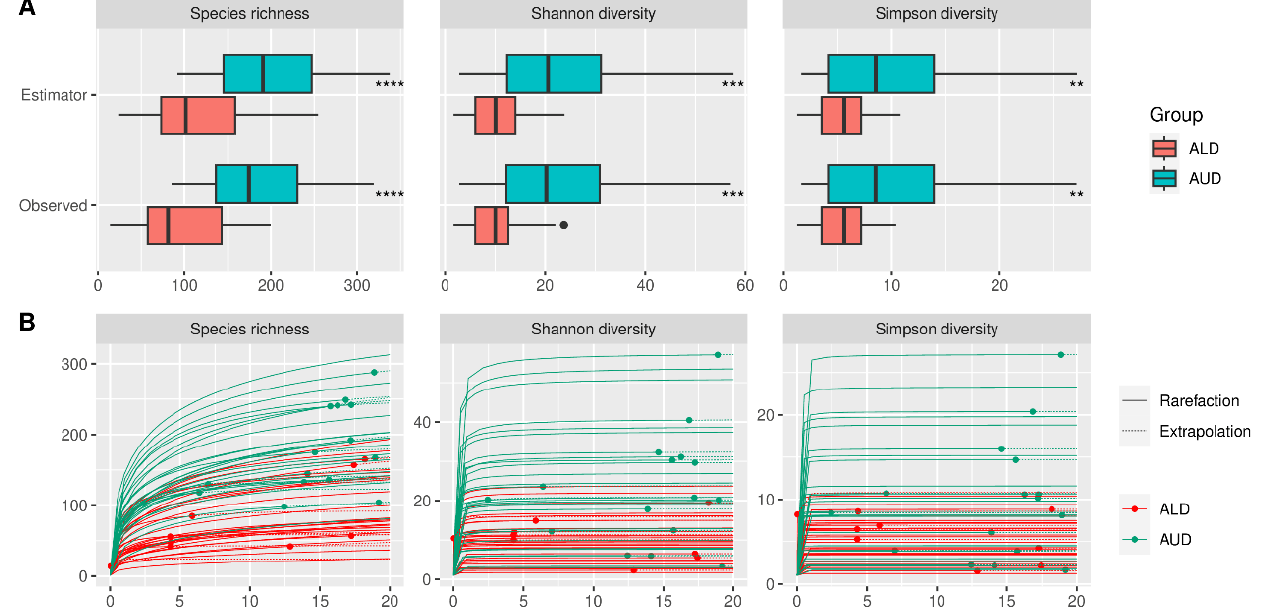
Figure 3. ( A ) Observed and estimated alpha diversity for comparison between patients with alcoholic liver disease and alcohol use disorder (without liver disease). ( B ) Rarefication–extrapolation curves for alpha-diversity measures. Each curve represents the alpha diversity of a single sample. Dots represent observed read depths, which were extrapolated to a common read depth of 20,000. Curves without dots indicate samples that had the read depth already above 20,000 and thus were rarefied to that level; ALD—alcoholic liver disease, AUD—alcohol use disorder, **— p < = 0.01, ***— p < = 0.001, ****— p < = 0.0001.